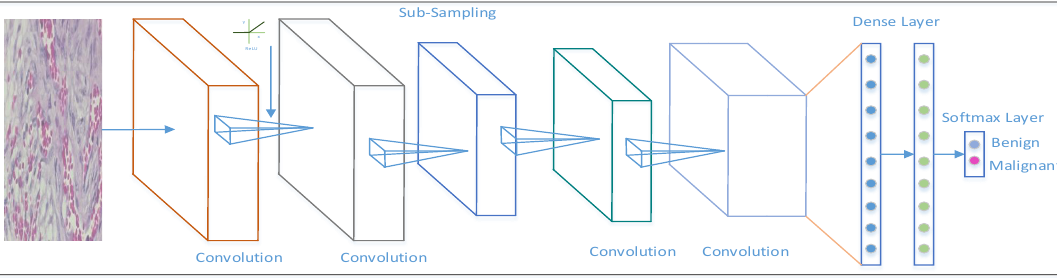
Figure 7. Work flow of a Convolutional Neural